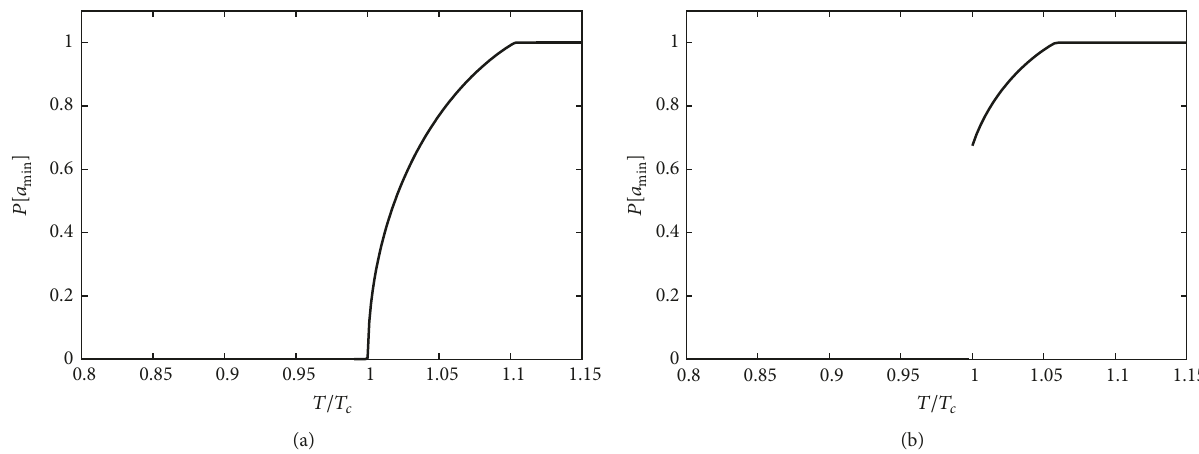
Figure 17: The Polyakov loop as function of the temperature (a) for SU (2) and (b) for SU (3)